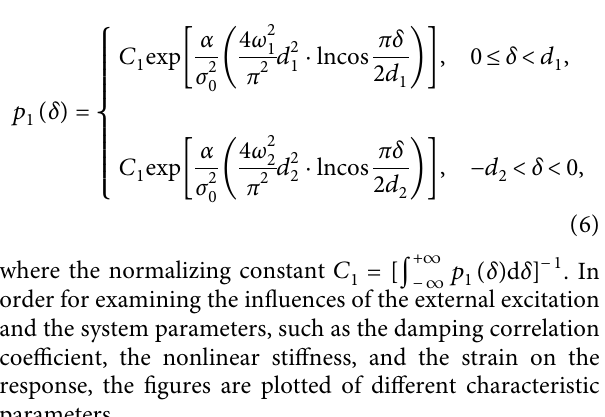
Figure 4: Comparison of joint PDF of the displacement and velocity of ATNPO. (a) Theoretical solution. (b) Numerical